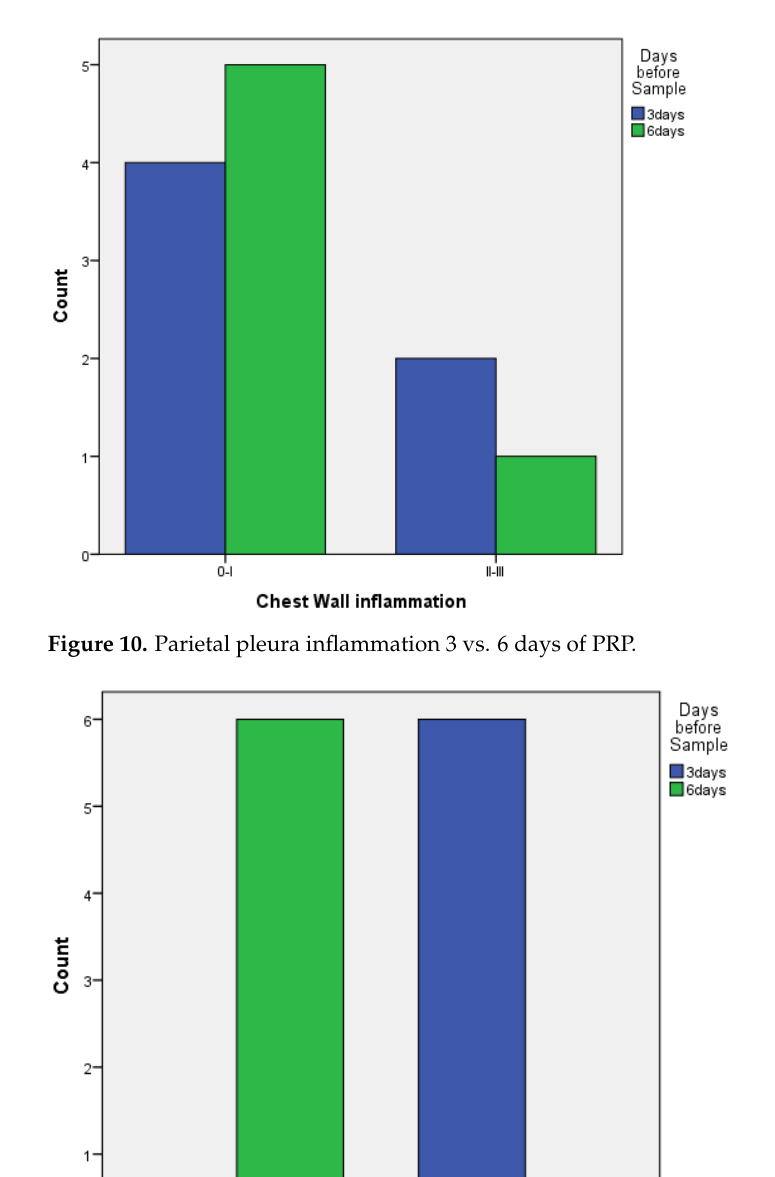
Figure 9. Visceral pleura inflammation 3 vs. 6 days of PRP.